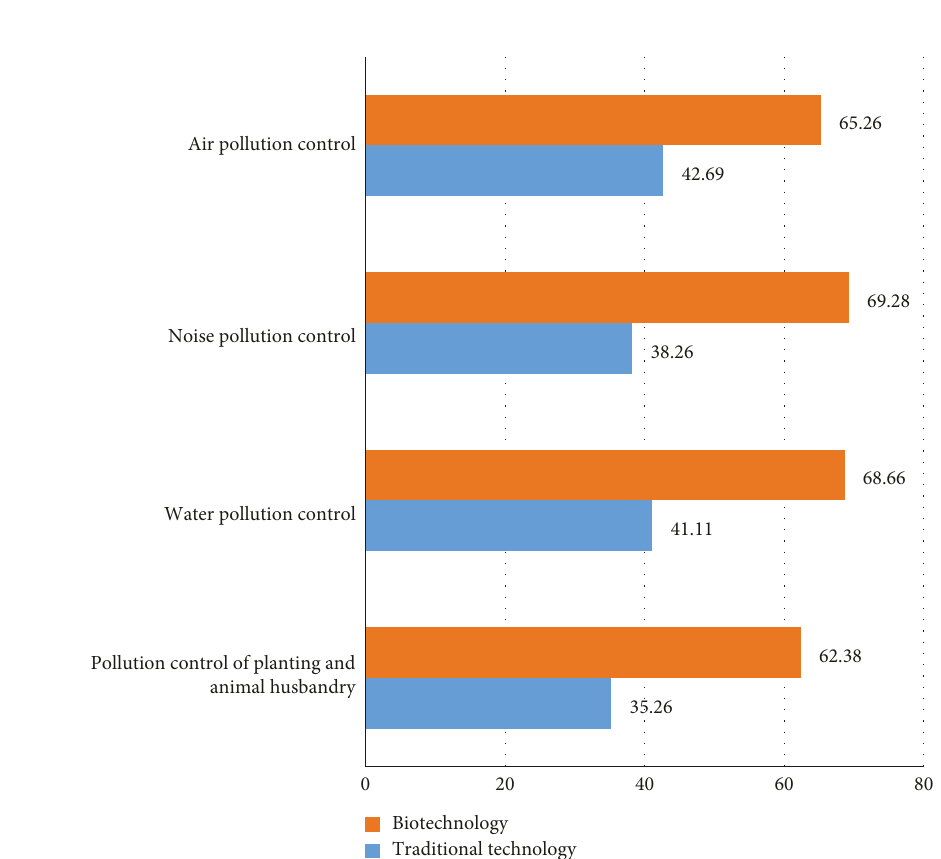
Figure 3: Comprehensive analysis of environmental pollution control of rural cultural industry under different technologies.